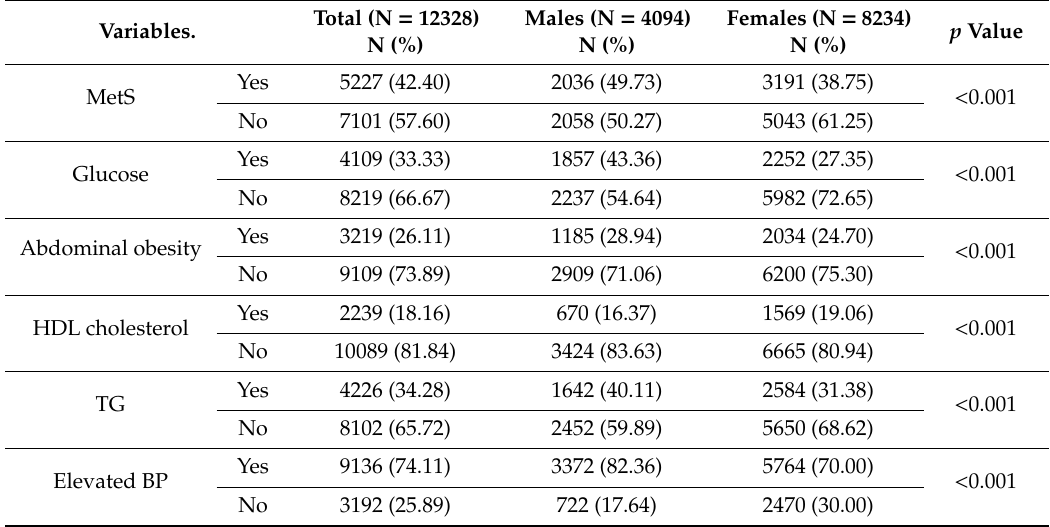
Table 2. Metabolic syndrome and its components in the subject